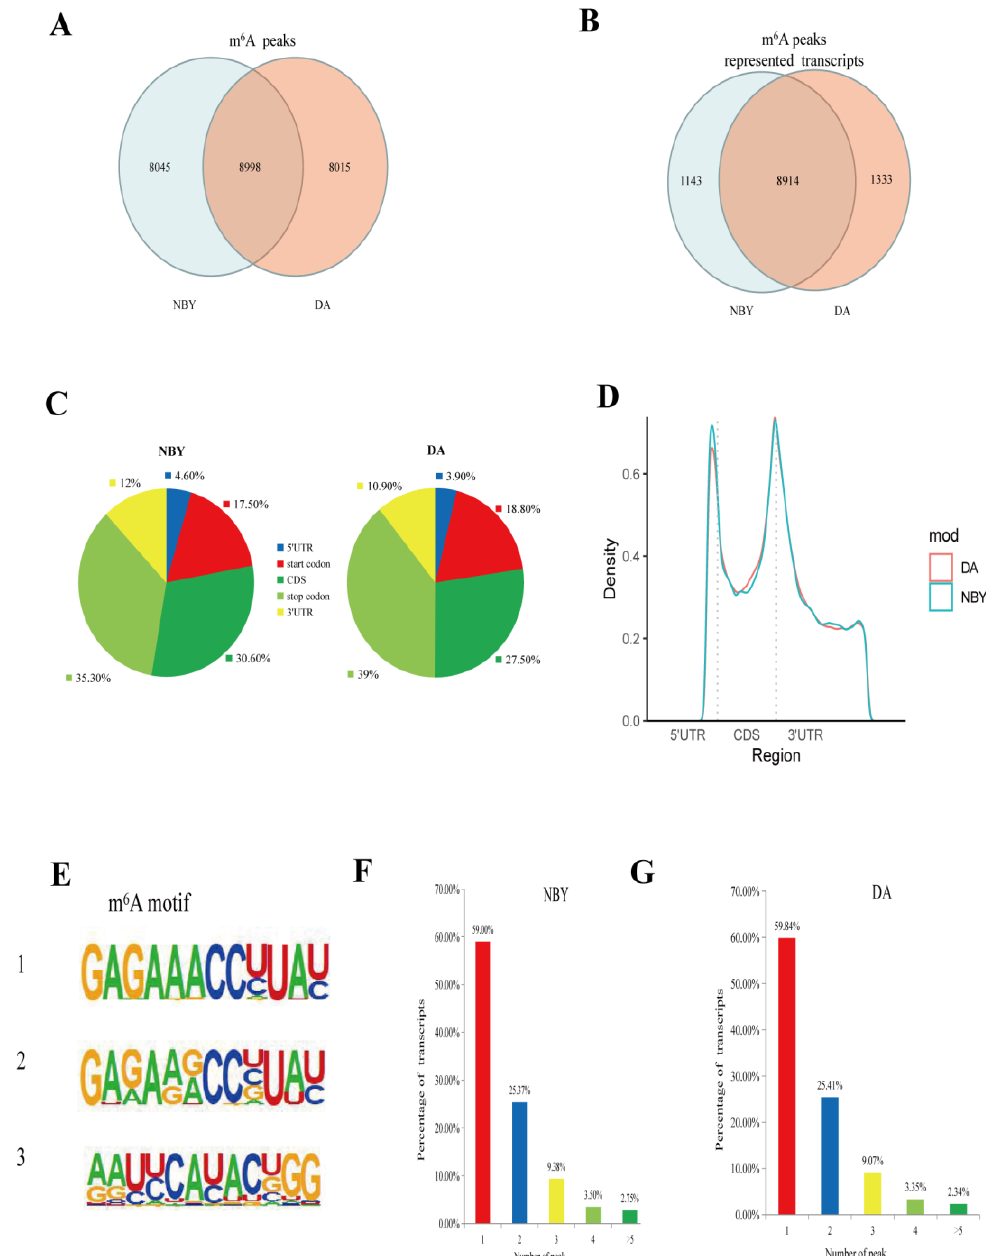
Figure 2. Transcriptome-wide m6A sequencing and m6A peaks analysis of NBY and DA. ( A ) Com- mon and unique m6A peaks in NBY and DA. ( B ) Venn diagram of m6A peaks-represented transcripts of two groups. ( C ) The proportion of m6A peaks distribution in the indicated regions in NBY and DA. ( D ) Enrichment of m6A peaks along with transcripts in NBY and DA. Each transcript was divided into three parts: 5 (cid:48) UTR, CDS, and 3 (cid:48) UTR. ( E ) The top three motifs enriched across m6A peaks identified from NBY and DA. ( F ) The distribution of m6A-modified peaks per gene in NBY m6A genes. ( G ) The distribution of m6A-modified peaks per gene in DA m6A